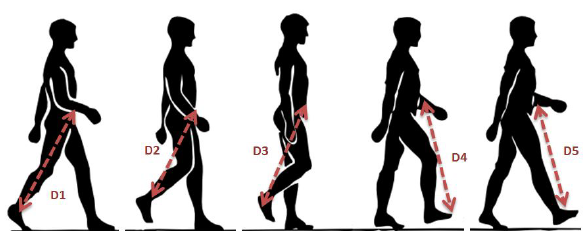
Figure 5. Distance variation between transmission node and base station while